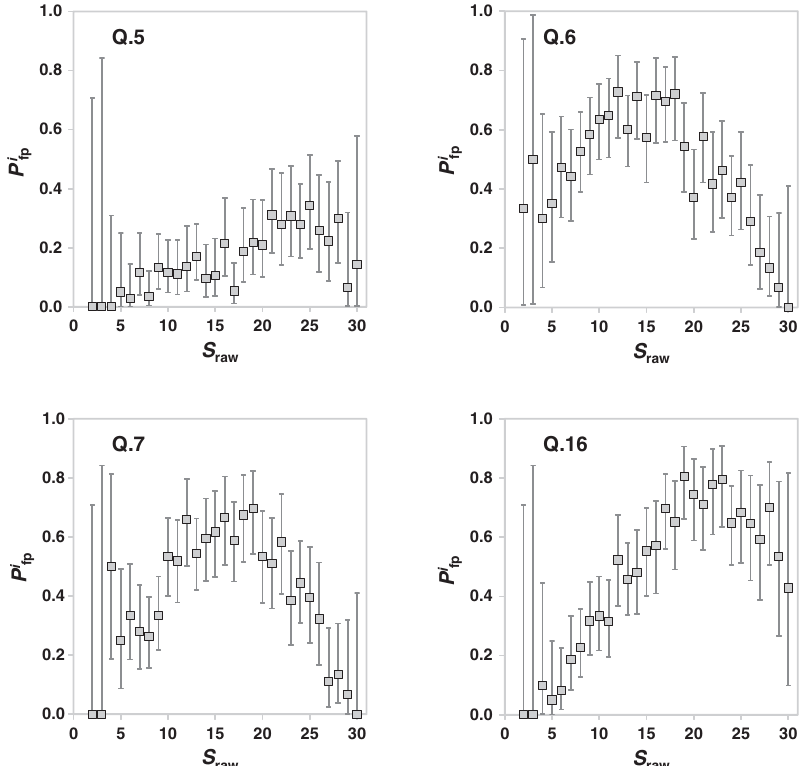
FIG. 5. P i (vertical axis) of Q.5, 6, 7, and 16 for each group of students with a given S fp Clopper-Pearson 95% confidence intervals of the dependent variable.